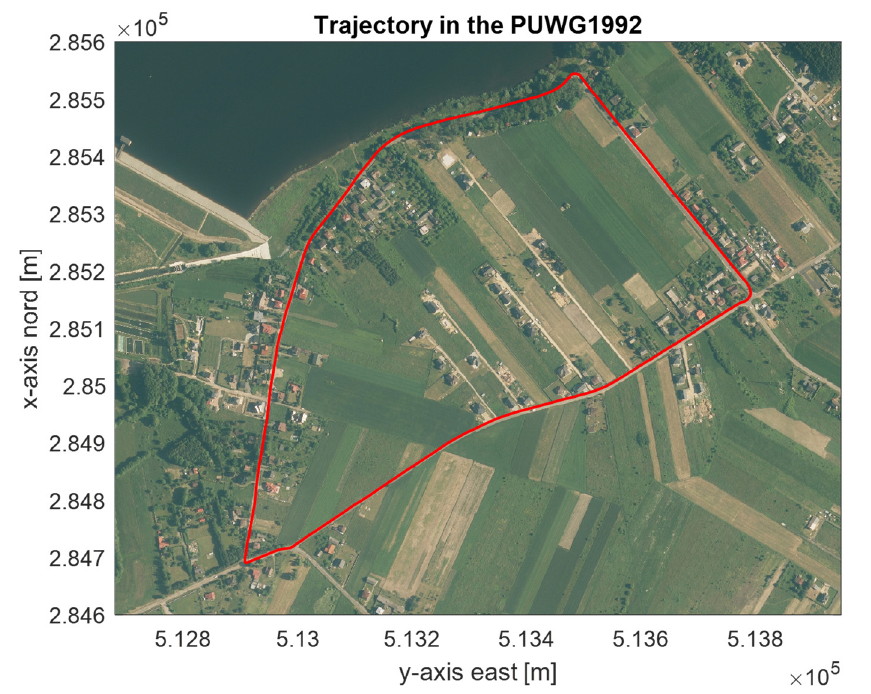
Figure 7. An exemplary trajectory against the background of an orthophoto